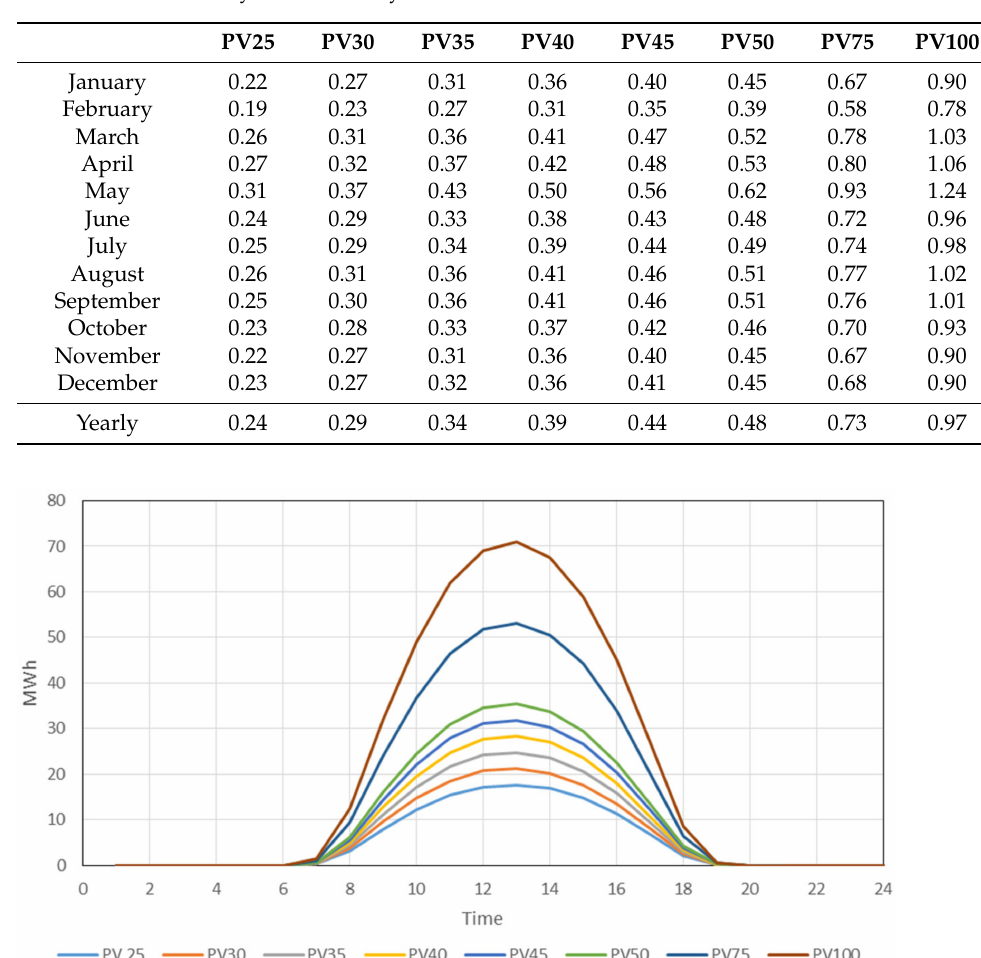
Table 1. Self-sufficiency ratios of PV systems.